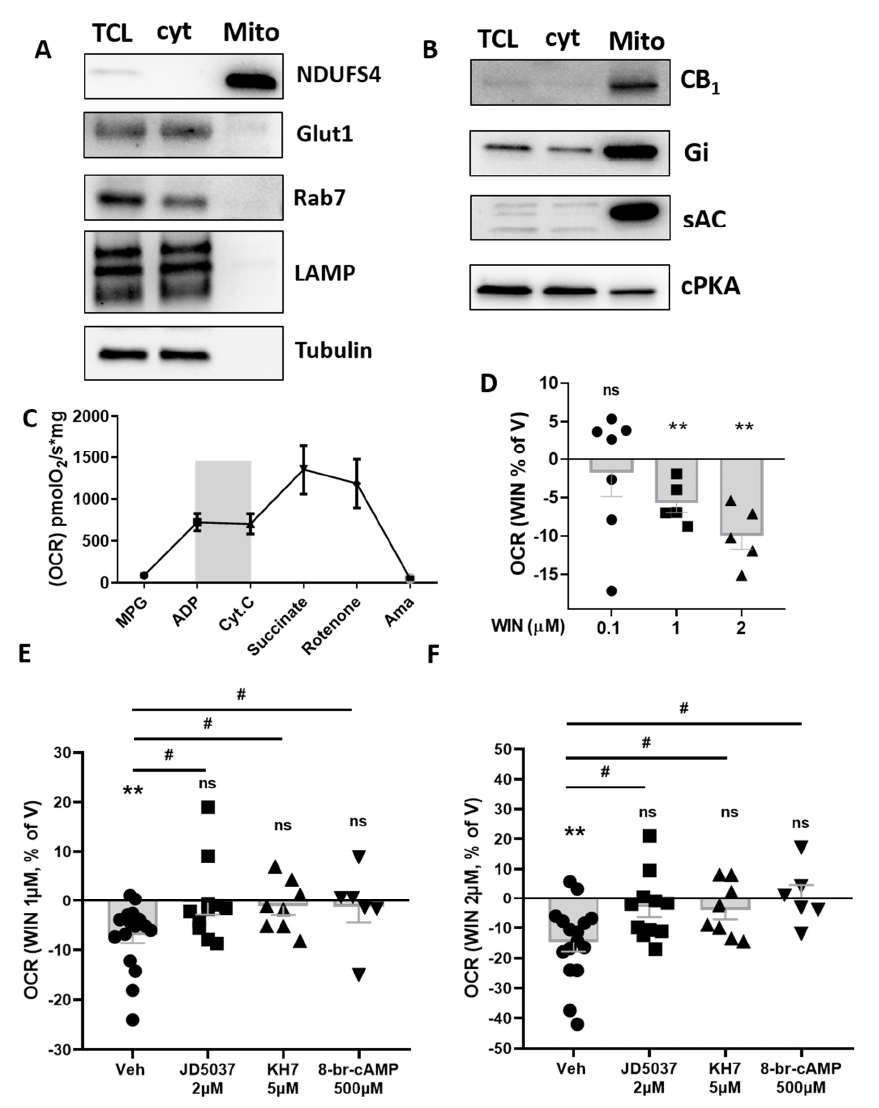
Figure 3. Effect of CB 1 stimulation and the relative intramitochondrial pathway involved in isolated eWAT mitochondria . ( A ) Western blotting of isolated mitochondria extracts (mito) from rat eWAT compared to total cell lysate (TCL) and cytoplasmic (cyt) fraction. Membranes were incu- bated with antibodies against NADH:ubiquinone oxidoreductase subunit S4 (NDUFS4, mitochon- drial marker), glucose tansporter-1 (Glut1, plasma membrane marker), Ras-related protein Rab-7a (Rab7, endosomes marker), lysosomal-associated membrane protein-2 (LAMP, lysosomes marker), and tubulin (cytoplasm marker). ( B ) Western blotting of isolated mitochondria extracts (mito) from rat eWAT compared to total cell lysate (TCL) and cytoplasmic (cyt) fraction. Membranes were incu- bated with antibodies against CB 1 receptor, Gi protein, sAC (soluble adenylyl cyclase), and cPKA (catalytic subunit of protein kinase A). ( C ) Oxygen consumption rate (OCR) in isolated mitochon-